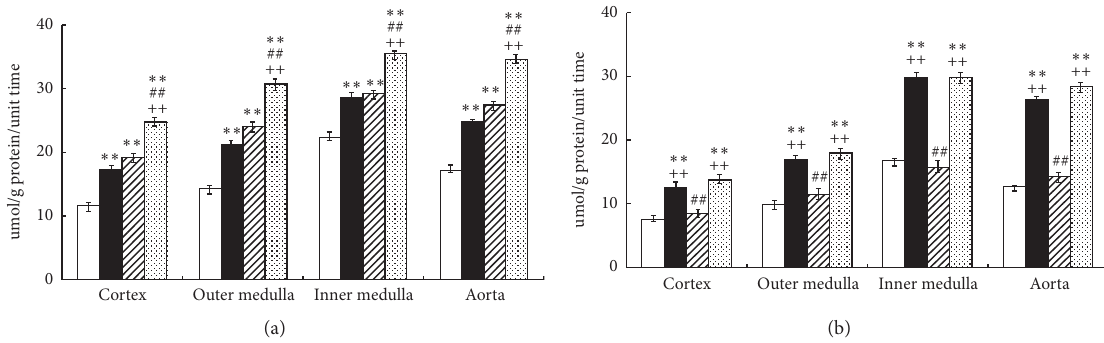
Figure 5: Effects of Ex and tempol on NOS activity in SHR and WKY. The NOS activity in the renal cortex, outer medulla, inner medulla, and aorta of SHR (a) and WKY (b) was compared among the control group (open bars), Ex group (closed bars), Tmp group (hatched bars), and Ex +Tmp group (checked bars) ( n � 10 in each group). ∗ P < 0 . 05 vs. the control group. ∗∗ P < 0 . 01 vs. the control group. ## P < 0 . 01 vs. the Ex group. ++ P < 0 . 01 vs. the Tmp